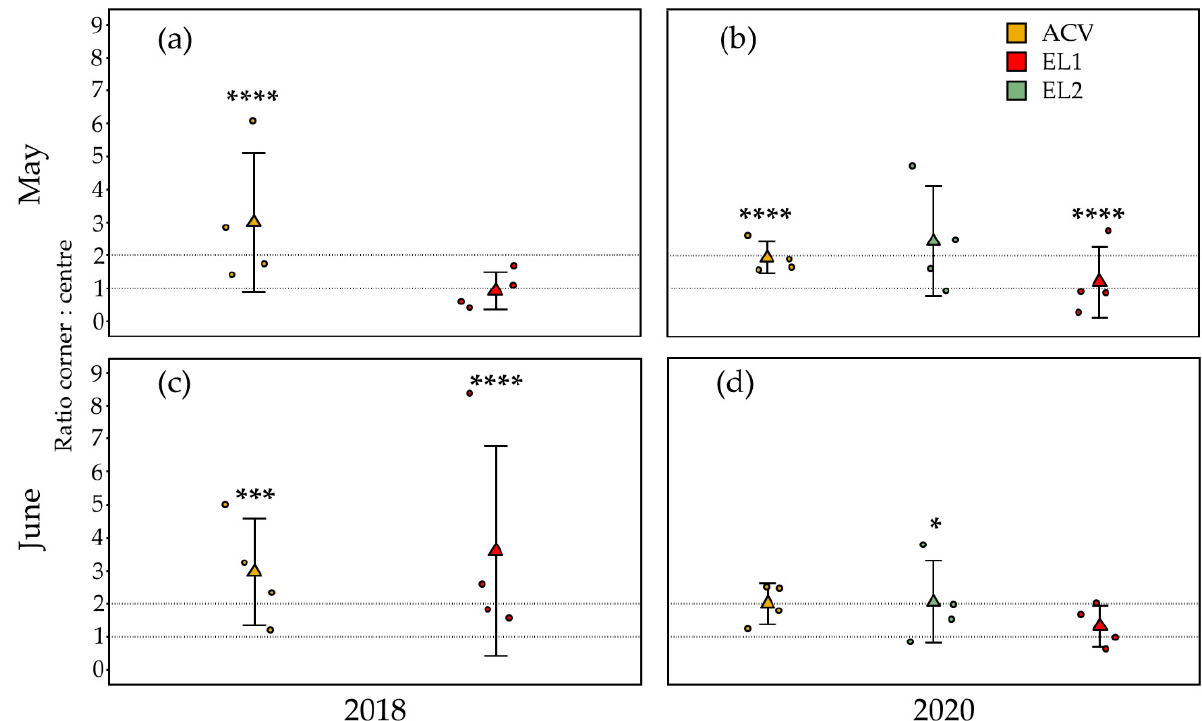
Figure 1. Corner to centre trap catch ( D. suzukii ) ratios for the two and three attractants tested in spring 2018 and 2020, respectively, at 5 m inter-trap spacing. Jittered points represent the ratio per replicate ( n = 4) grid, triangles depict their mean and error bars are standard deviations. Asterisks above graphs refer to the level of significance regarding the difference in counts between corner and centre traps ( n = 16) analysed for each attractant and period (GLMM, * ≤ 0.05, ** ≤ 0.01, *** ≤